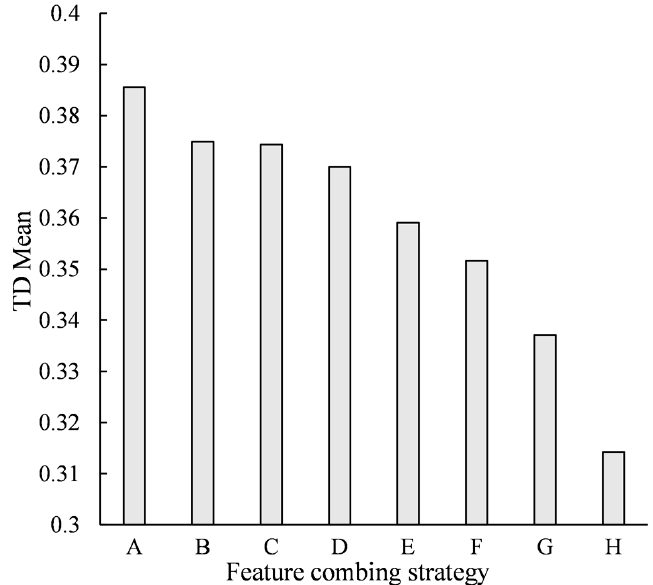
Figure 6. TD Mean values of the feature combing strategies. A: 5 bands+MI 13 ; B: 5 bands + MI 13 + NDI 23 + DI 23 ; C: 5 bands + MI 13 + DI 23 ; D: 5 bands+MI 13 +NDI 23 ; E: 5 bands ++ NDI 23 ; F: 5 bands + DI 23 ; G: 5 bands + NDI 23 + DI 23 ; H: 5 bands.